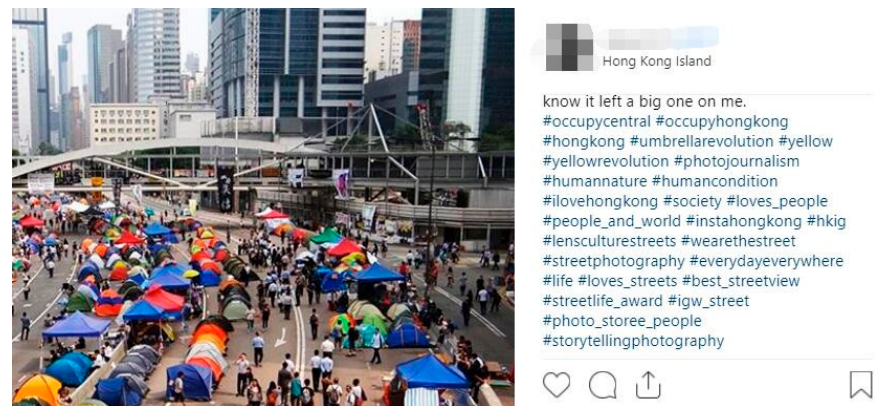
Figure 2. Photo sample from Instagram. The photo has a title with multiple hashtags (e.g., #occupycentral, #umbrellarevulotion, #best_streetview) to annotate, indicating potential topics for the